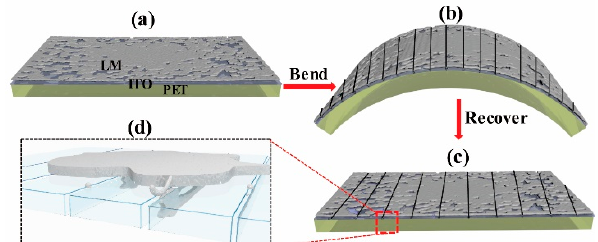
Figure 2. Schematic drawing of the structure and mechanism of the self-healing flexible conductive film. ( a ) Structure of the flexible film consisting of a poly(ethylene terephthalate) (PET) substrate (bottom), indium tin oxide (ITO) film (middle), and LM droplets (top). ( b ) Bending of flexible films creates multiple defects (crevices) on the ITO. ( c ) Repair of the defects via the conductive LM droplets, which can flow and fill in crevices via capillarity. ( d ) Magnified view of the LM filling in